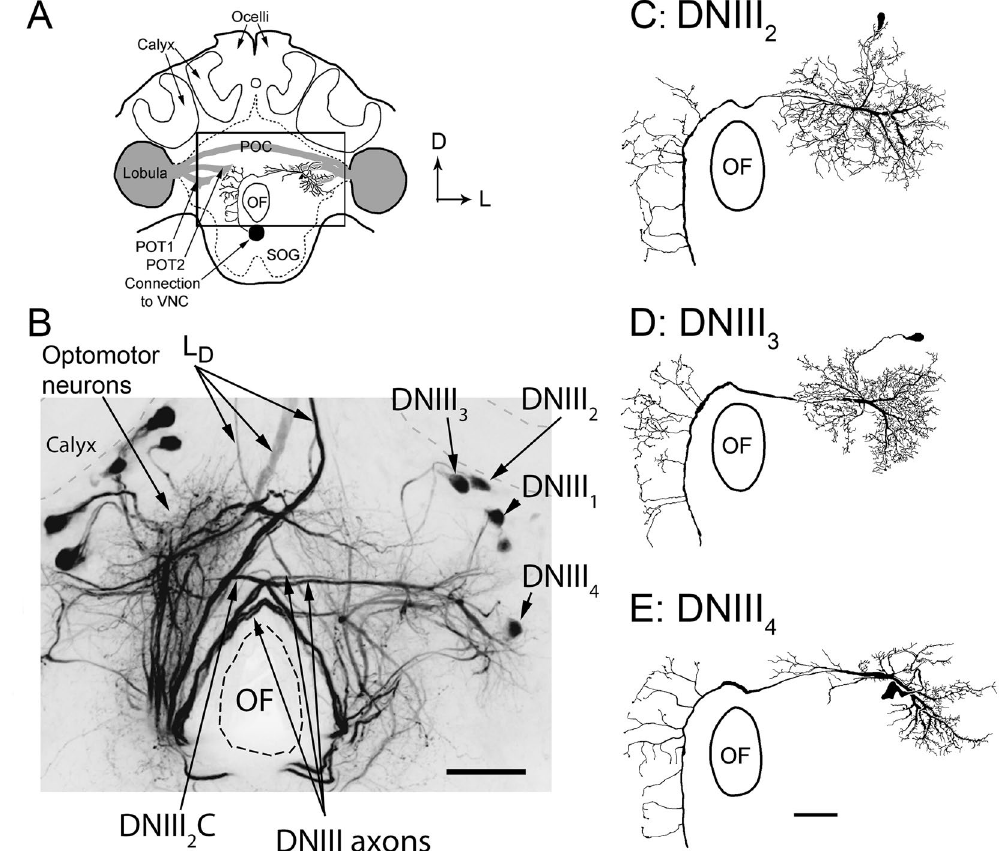
Figure 2. Brain anatomy. ( A ) A schematic diagram of the bee brain as viewed from the posterior perspective. The posterior optic tracts (POT1 and POT2) and the posterior optic commissure (POC) are shown in grey. The box shows the location of the image shown in B. ( B ) Photograph of a mass-fill obtained after placing dye in the ventral nerve cord. The optomotor neurons and the DNIII neurons are labeled. The axons of all four DNIII neurons in the left hemisphere of the brain were filled (labeled DNIII 1–4 ), only one DNIII 2 neuron was filled in the other side (labeled DNIII 2 C, with C = contralateral). (CDE) Drawings of high quality fills showing the anatomies of DNIII 2 , DNIII 3 and DNIII 4 . A high quality fill was not obtained from DNIII 1 . Scale bars = 100 µ m. OF = oesophageal